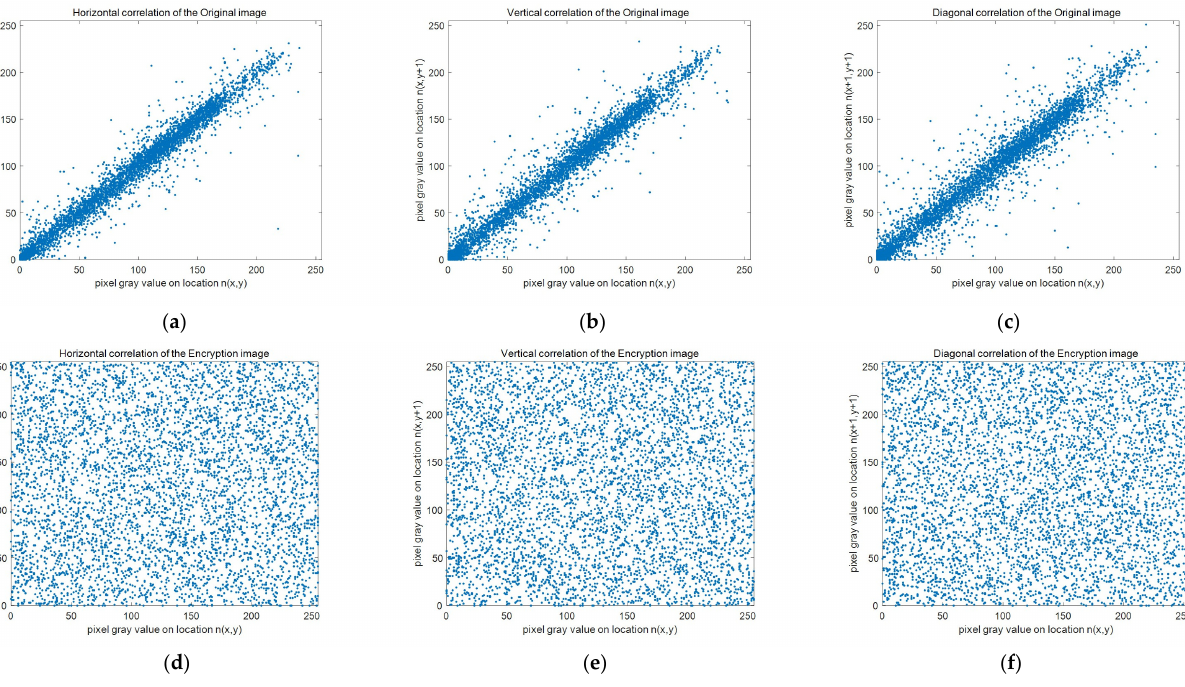
Figure 16. Adjacent pixel correlation of image 5.3.01: ( a – c ) original image; ( d – f ) encrypted image. Table 3. Pixel correlation in different directions.